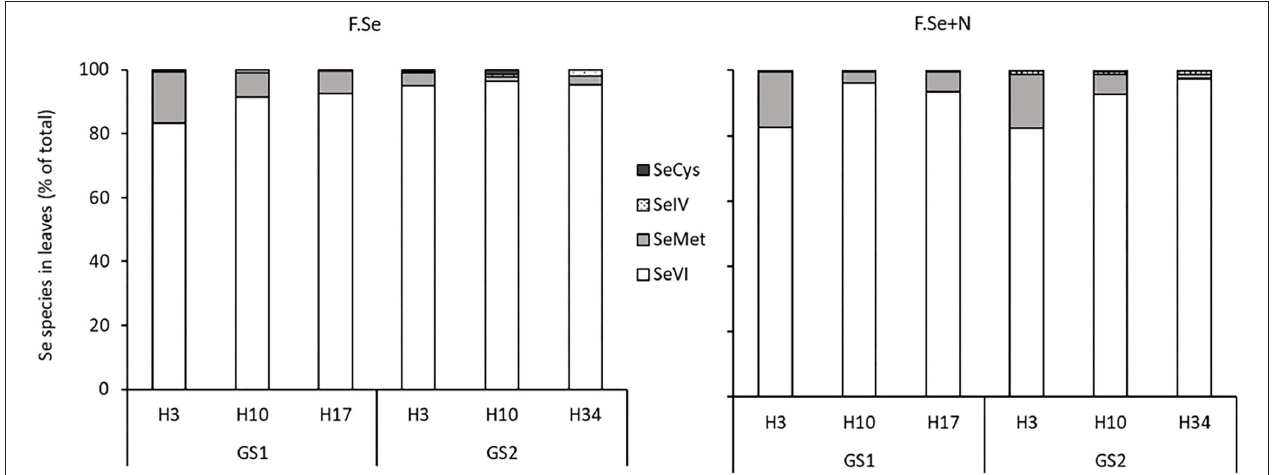
FIGURE 4 | The distribution of Se species as a percentage of the total Se in leaves that were treated with F.Se and F.Se + N and harvested at different times following application at stem elongation (GS1) and heading (GS2).